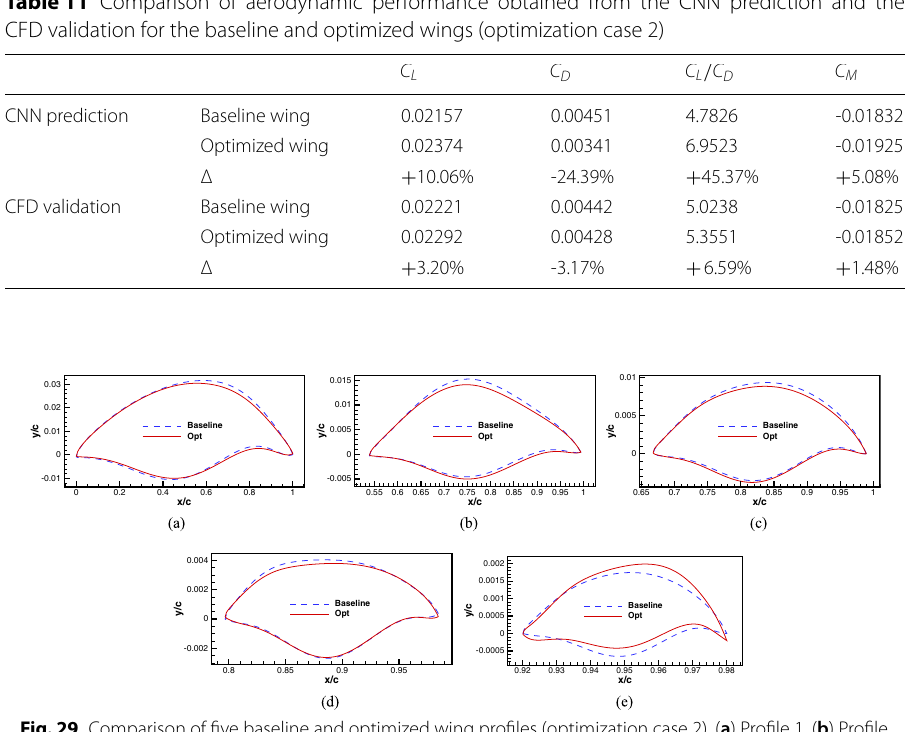
Fig. 29 Comparison of five baseline and optimized wing profiles (optimization case 2). ( a ) Profile 1, ( b ) Profile 2, ( c ) Profile 3, ( d ) Profile 4, ( e ) Profile